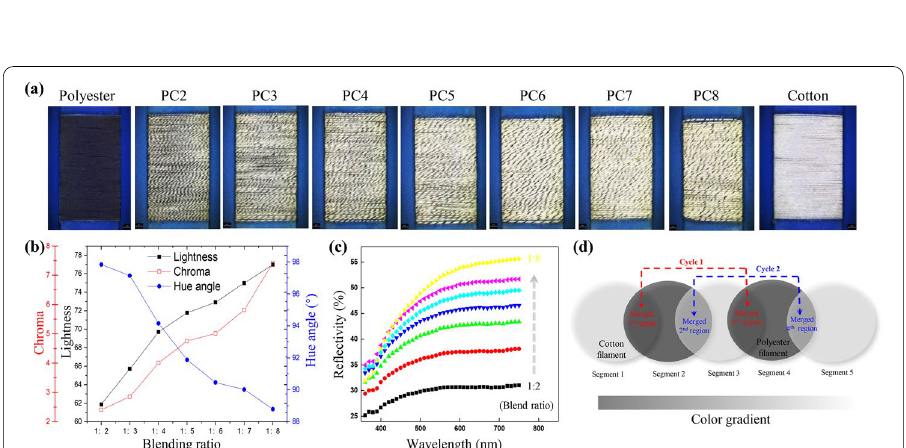
Fig. 3 a Optical observations of the segmented yarns wrapped on glass slides. b Lightness, chroma and hue angle measurements of the composite yarns. c Blend ratio induced changes of reflectivity. d Schematic analysis of interval color sense and